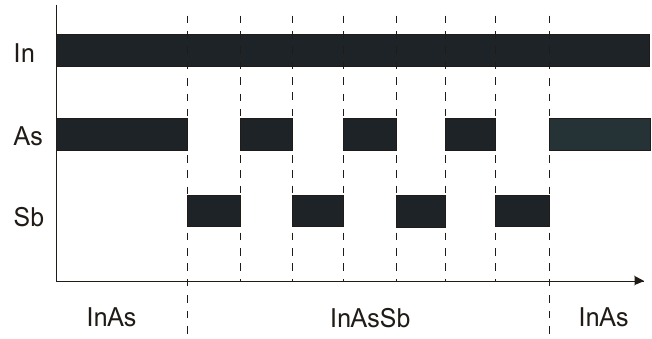
Figure 2. The scheme of the MMBE shutter sequence during the growth of InAs 0.76 Sb 0.24 and the surrounding InAs layers. The filled bars denote intervals when the corresponding shutters are open (after [37]).